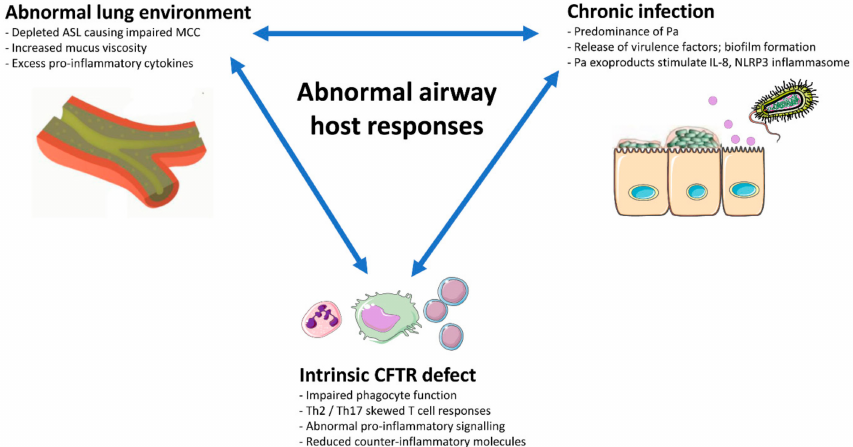
Figure 1. Factors a ff ecting airway host immune responses. Defective cystic fibrosis